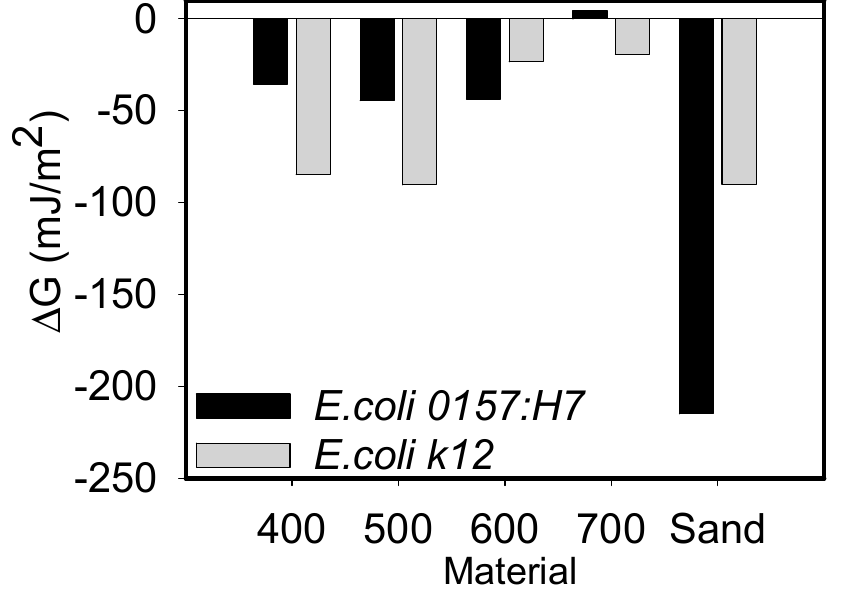
Figure 2. Comparison of the Gibbs free energies calculated for both bacteria strains and biochar types (400–700 °C) or sand in DIW. No statistical differences were measured between the various biochars and bacterial strains investigated.